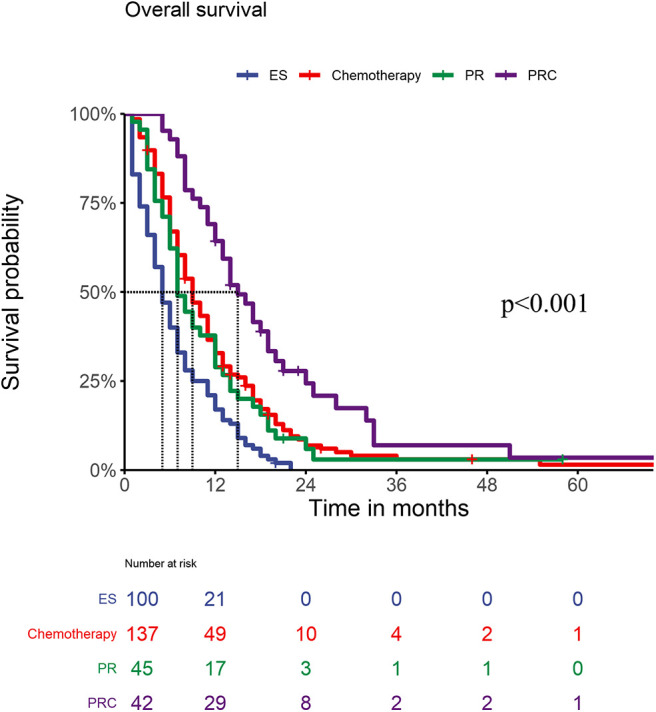
OS of PM patients within different treatments (PESvs.Chemotherapy < 0.001, P ESvs.PR = 0.004, PESvs.PRC < 0.001; PChemotherapyvs.PR =0.519, P Chemotherapyvs.PRC = 0.001; P PRvs.PRC = 0.001).